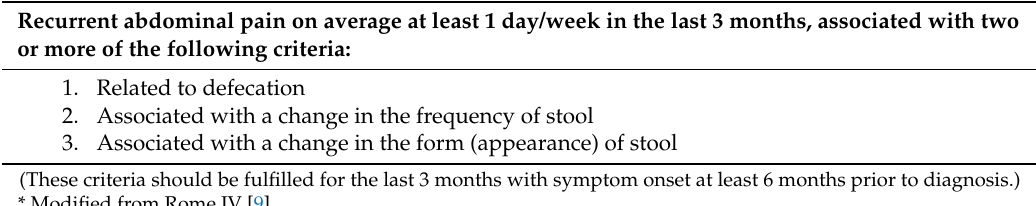
Table 1. IBS Diagnostic Criteria